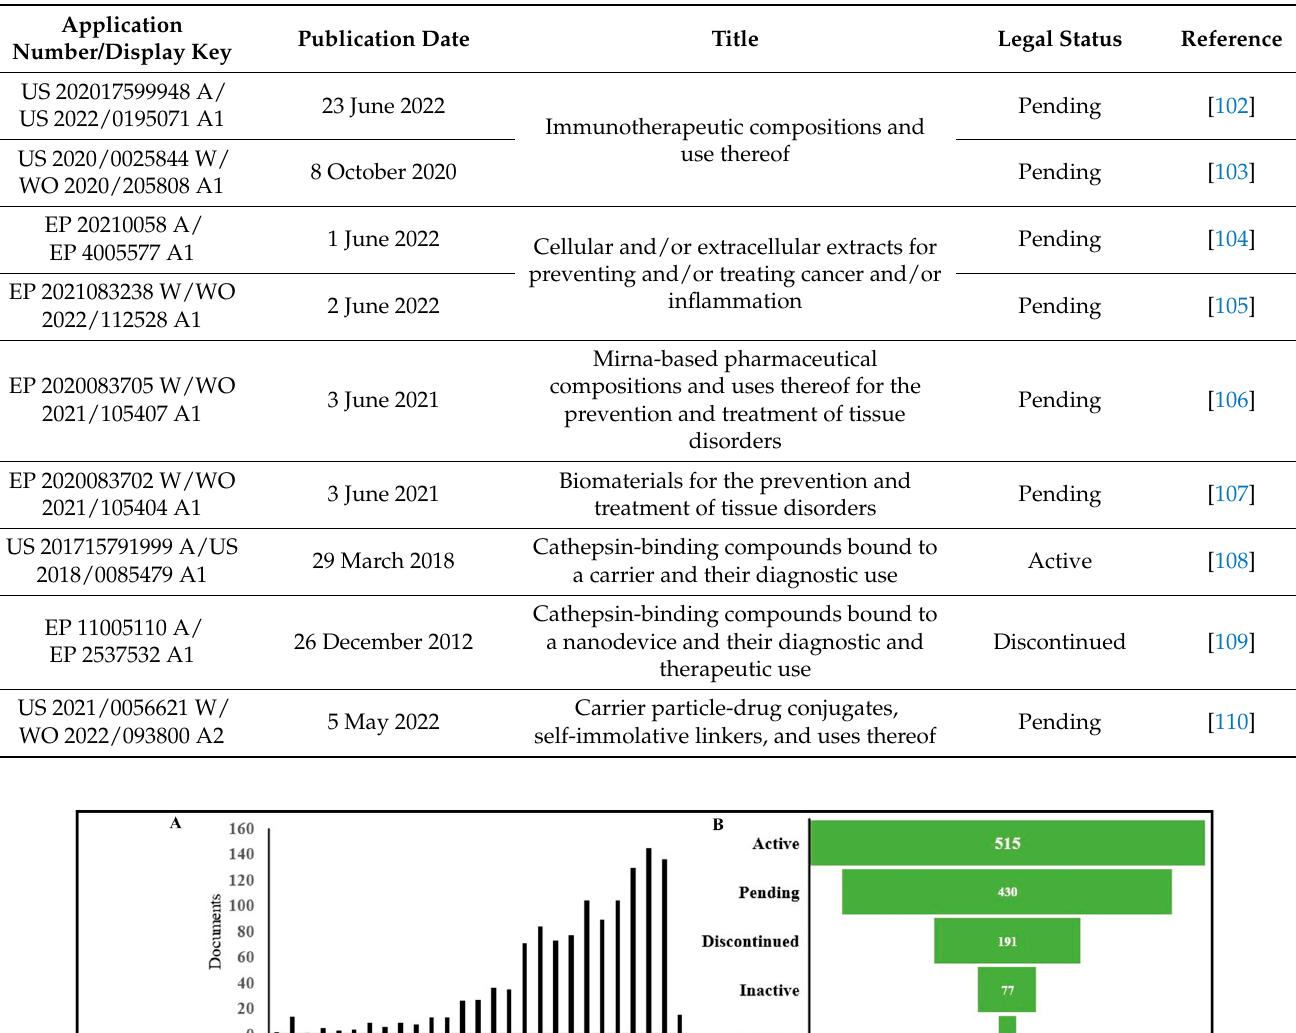
Table 2. Patents on Nano-gel for Skin Cancer.